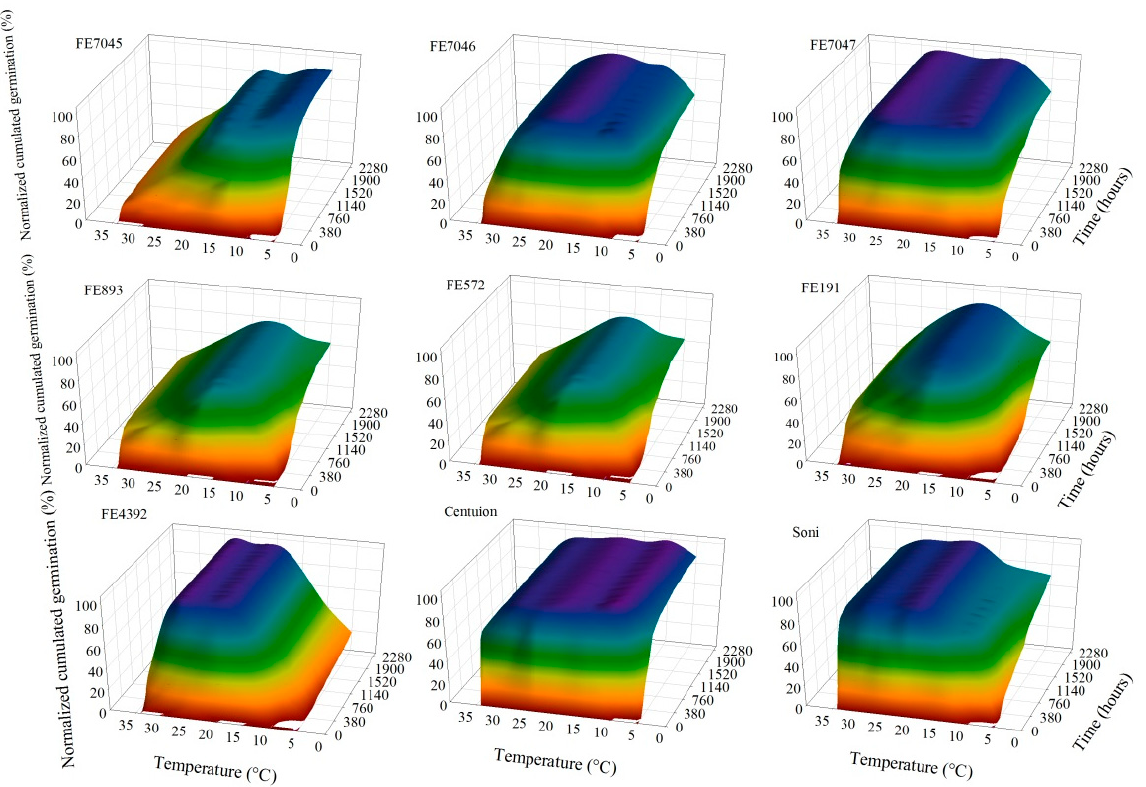
Figure 1. Temperature and time course response–surfaces of the normalized cumulative germination percentage of nine accessions of F. arundinacea .